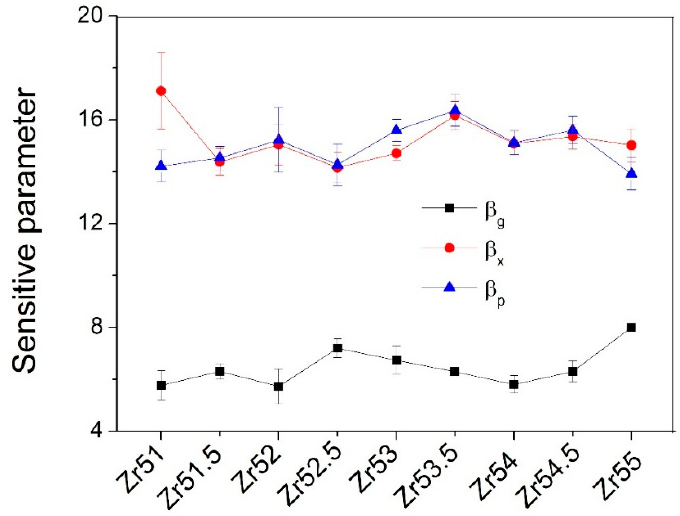
Figure 9. Relationship between the sensitive parameter β and the Zr content.